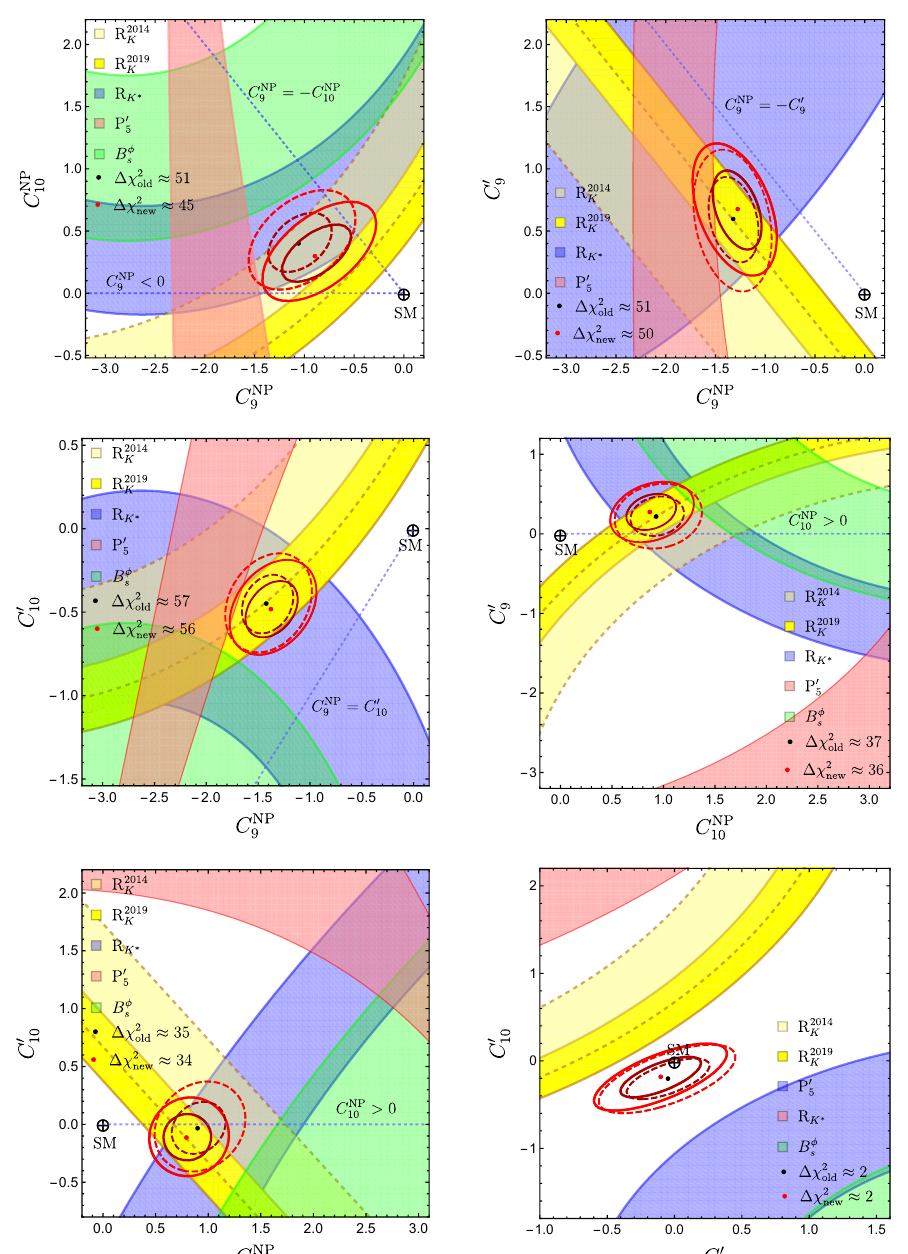
Figure 1 . The 1 (cid:27) allowed bands for R K (1 : 0 GeV 2 < q 2 < 6 : 0 GeV 2 ) before and after 2019 update, R K (cid:3) in the central bin (1 : 0 GeV 2 < q 2 < 6 : 0 GeV 2 ), P 0 (4 : 0 GeV 2 < q 2 < 6 : 0 GeV 2 ) from ATLAS 5 and LHCb, and B (cid:30) (cid:17) B ( B s ! (cid:30)(cid:22) + (cid:22) (cid:0) ) in the range (1 : 0 GeV 2 < q 2 < 6 : 0 GeV 2 ), for the six 2D s scenarios. The 1 (cid:27) and 2 (cid:27) allowed regions from the global (cid:12)t using data before (after) the 2019 R K update are shown by dashed (solid) contours. Speci(cid:12)c 1D sub-scenarios that give a good (cid:12)t to the data are also shown.